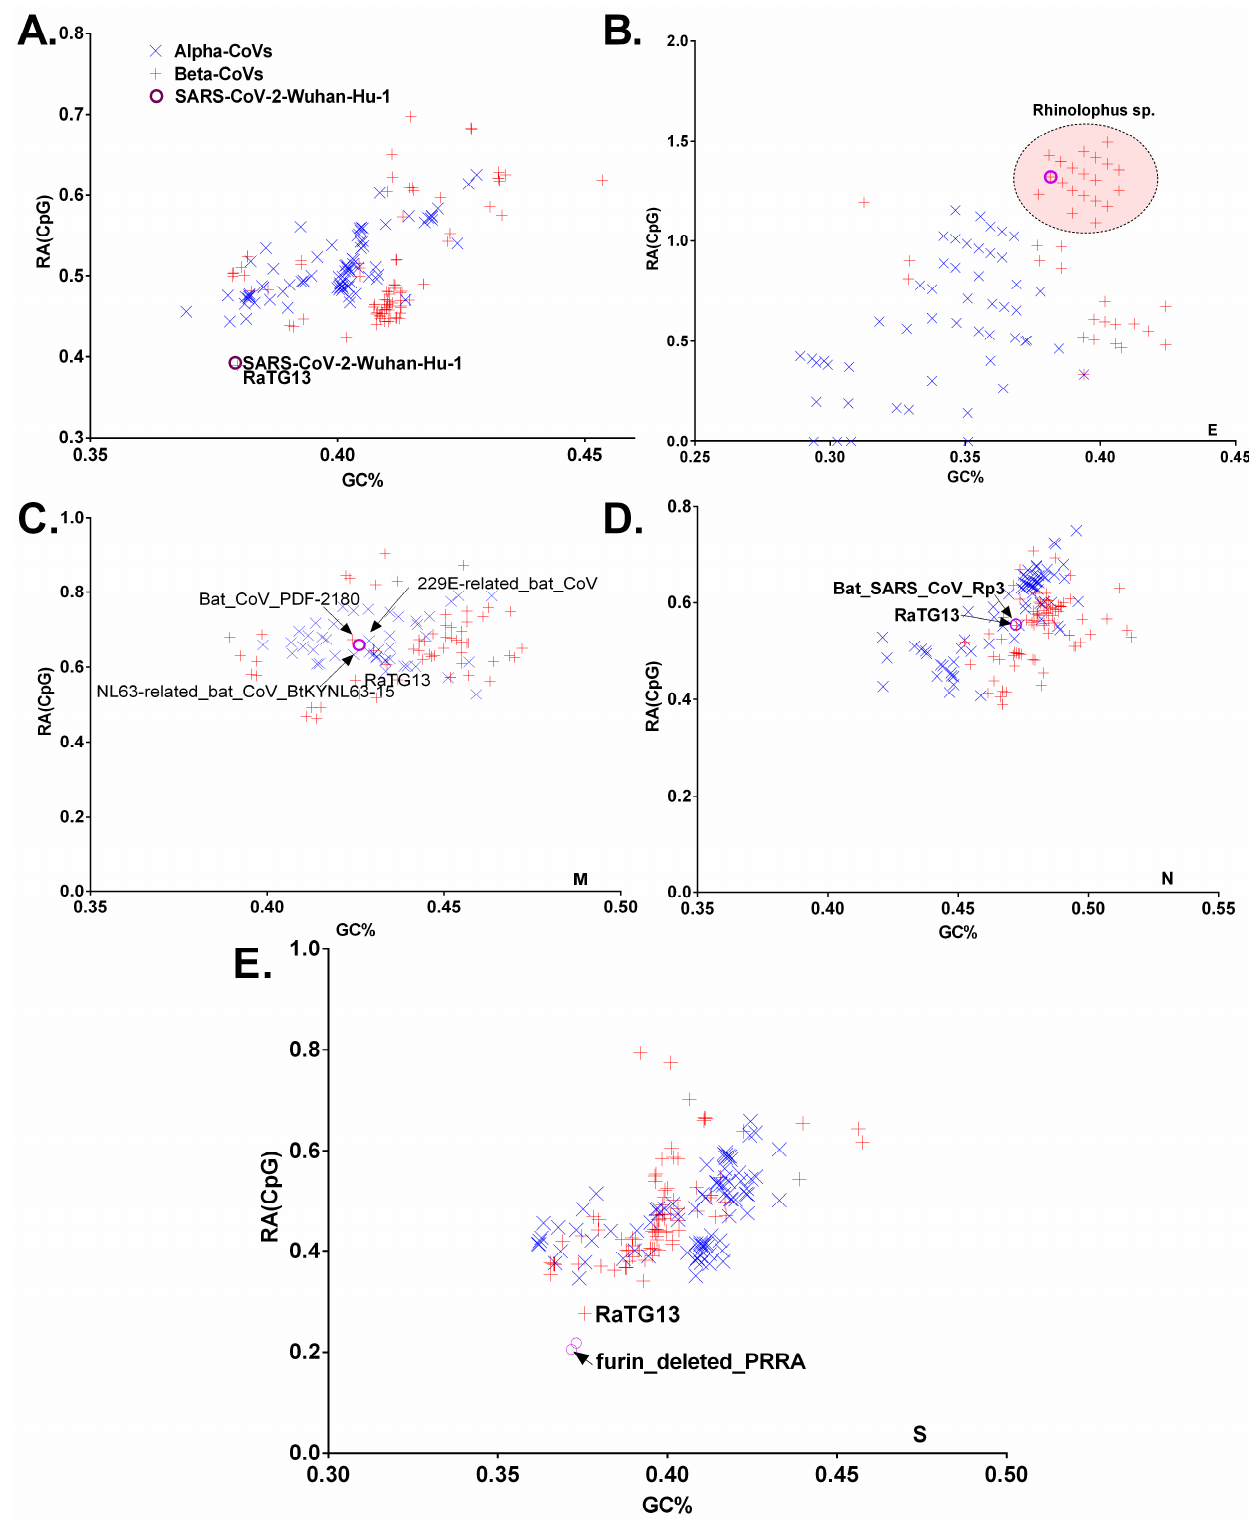
Figure 4. A plot of virus genomic RA CpG against GC% in the entire coding genomic sequences ( A ), envelope ( B ), membrane ( C ), nucleo-capsid ( D ), and spike ( E ) encoding sequences of chiroptera-hosted alpha- and beta-CoVs. The closest matches with SARS-CoV-2 based on the shortest Euclidean distance are shown. The viruses infecting Rhinolophus sp. are red-encircled in Figure 4B, and SARS-CoV-2 is represented by a small purple circle.